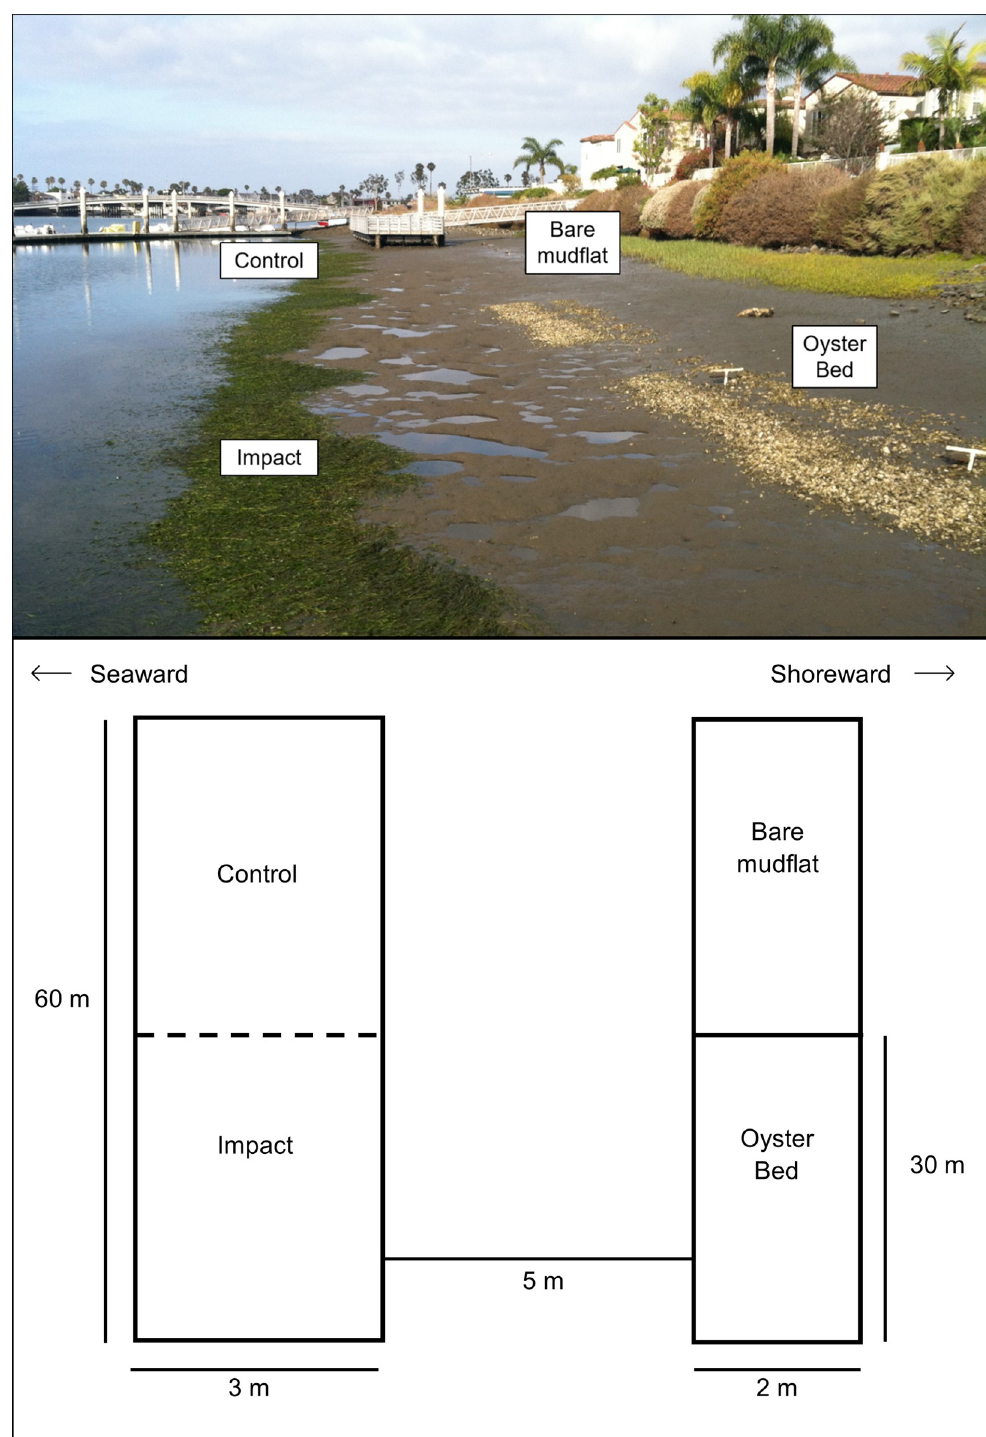
Fig 1. Orientation of control and impact eelgrass locations within Jack Dunster Marine Reserve (JDMR). Impact and control eelgrass locations in relation to a shoreward oyster bed constructed in June